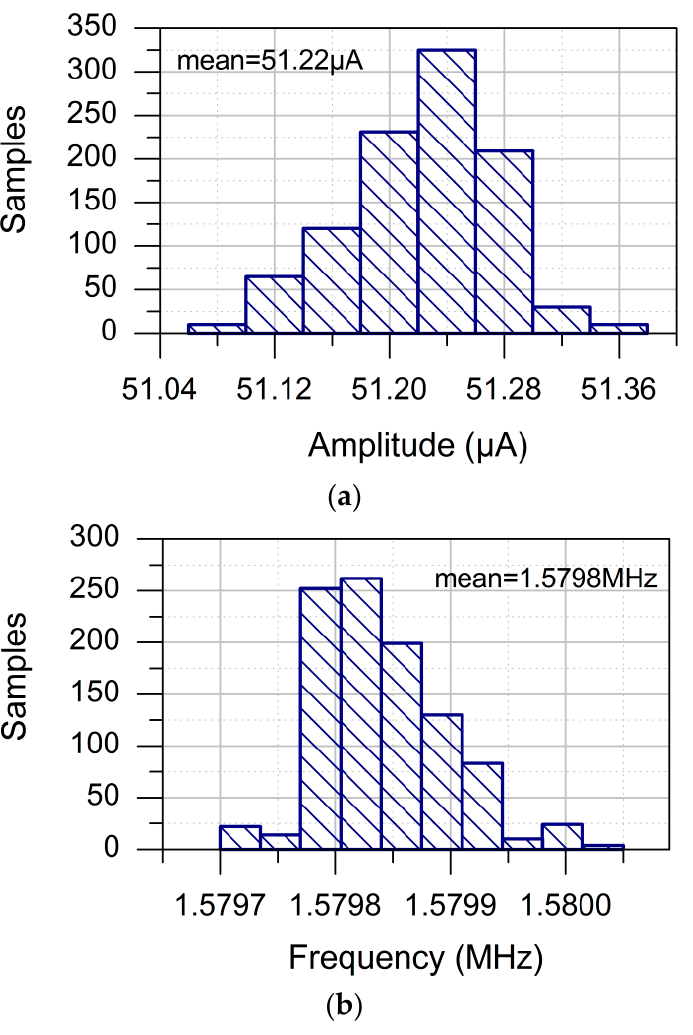
Figure 9. Monte Carlo simulation results for the variation in capacitor value: ( a ) histogram for maximum amplitude; ( b ) histogram for pole frequency.